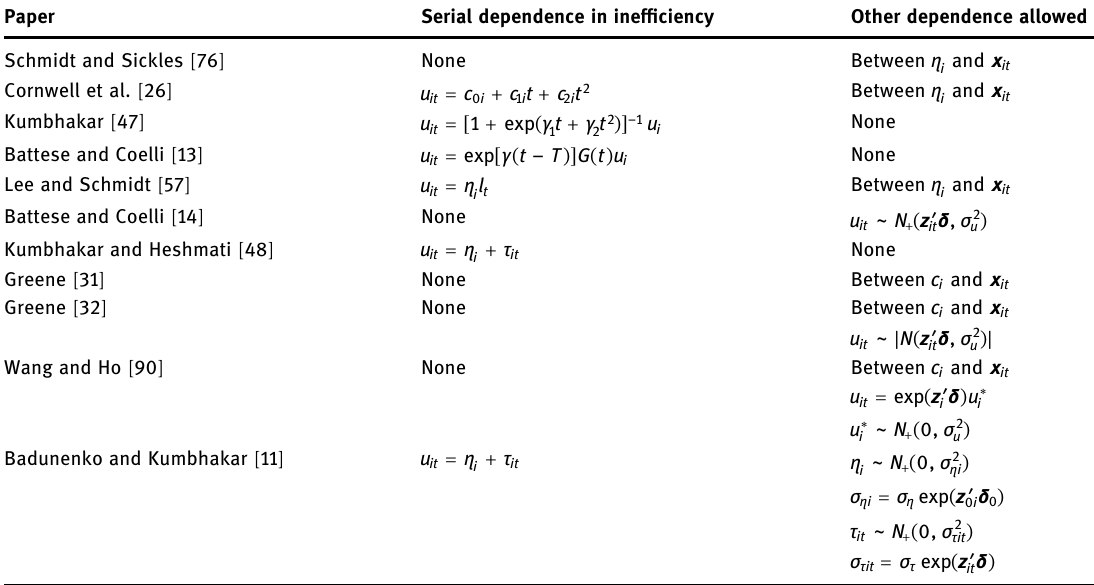
Table 1: Selection of panel data methods Paper Serial dependence in ine ffi